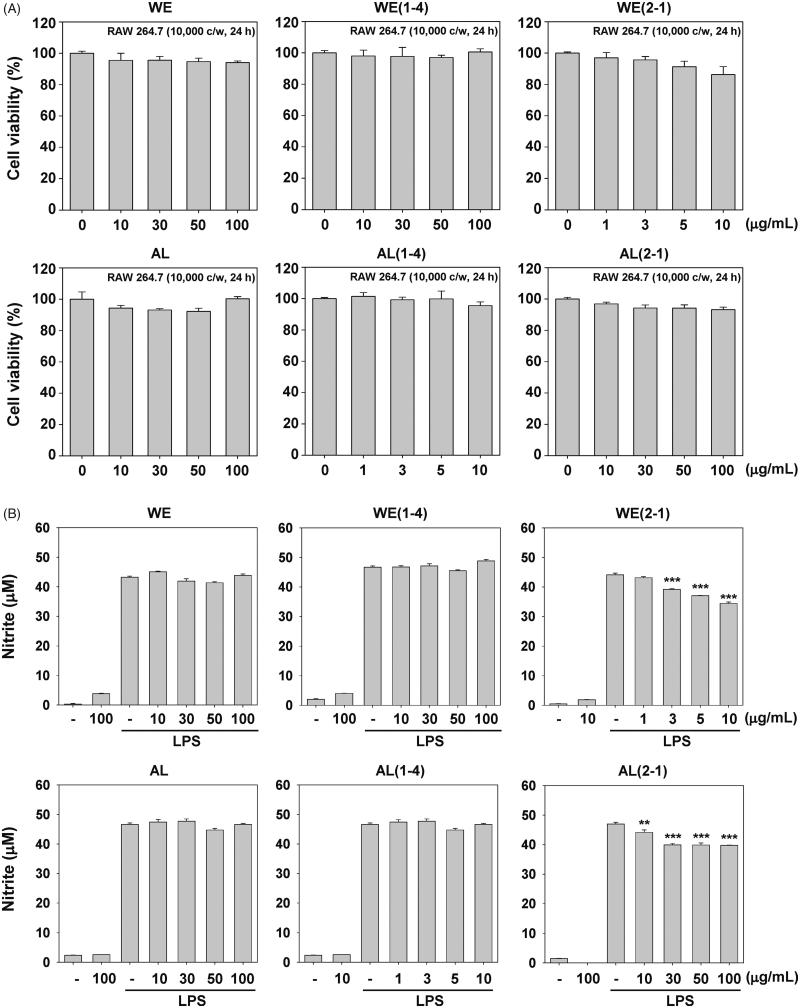
Inhibition of the WE(2-1) and AL(2-1) on LPS-induced nitric oxide (NO) in RAW 264.7 macrophages. (A) RAW 264.7 cells (1 × 104 cells/well) were treated with the indicated concentrations of various extracts for 24 h and cell viability was determined by MTT assay. Results of independent experiments were averaged and are shown as percentage cell viability compared with the viability of untreated control cells. (B) The nitrite production was measured by the Griess reaction assay method as described in the methods section. Cells were pre-treated with indicated concentrations of various extracts for 2 h and stimulated with LPS (1 µg/mL) for 22 h. The values obtained were compared with those of standard concentrations of sodium nitrite dissolved in RPMI 1640 medium, and the concentrations of nitrite in a conditioned media of sample treated cells were calculated. Data were obtained from three independent experiments and were expressed as means ± SD. ***p < 0.001 indicates significant differences from the unstimulated control group.